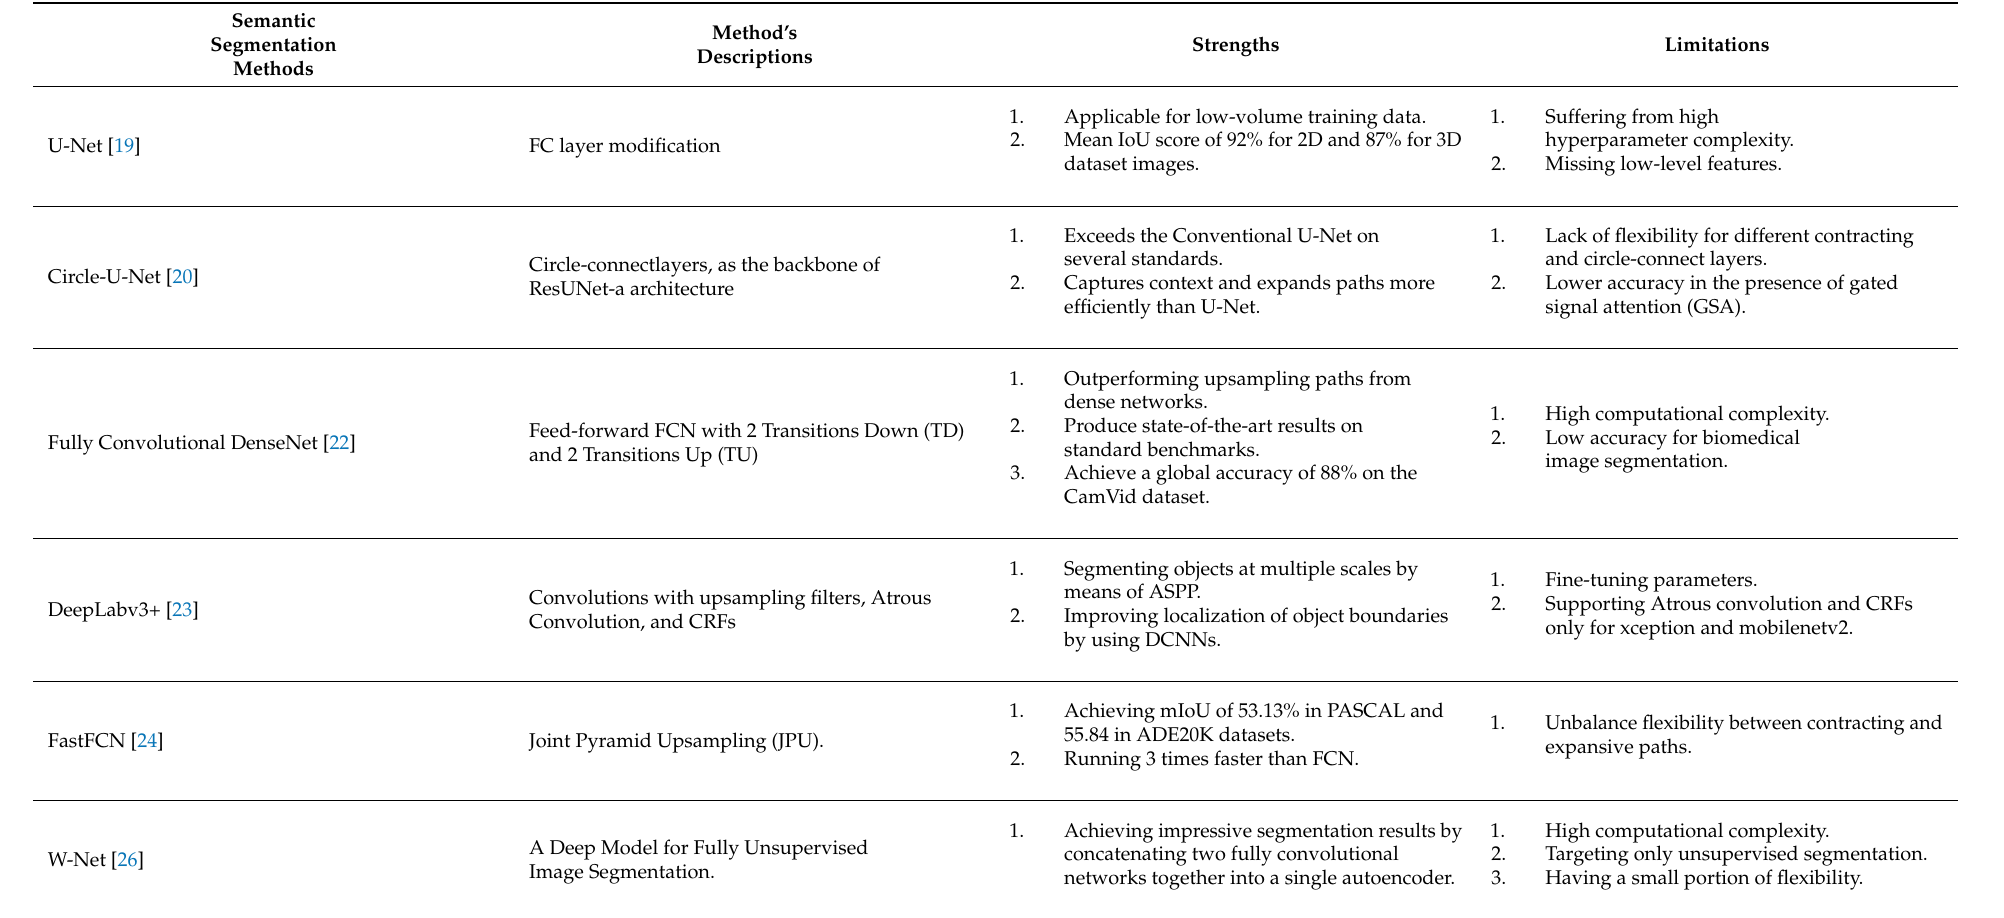
Table 1. A summary of deep learning semantic segmentation methods for medical